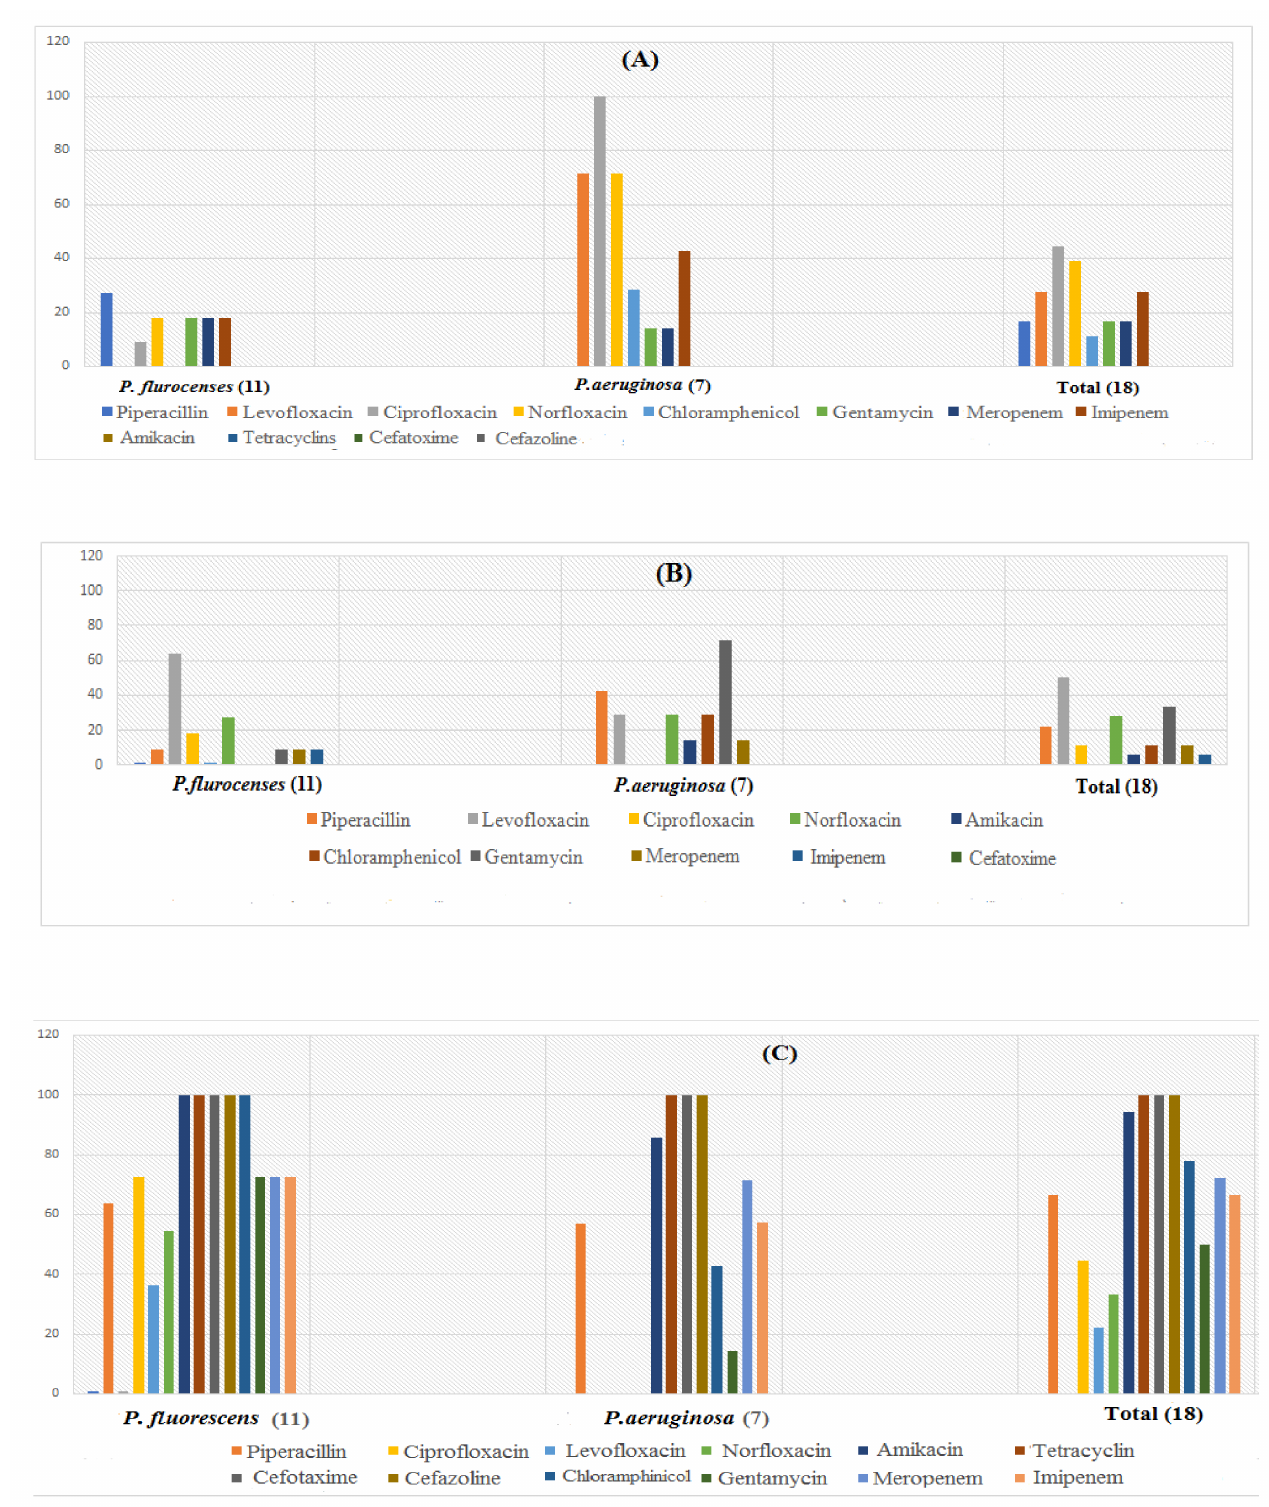
Figure 1. Results of an antimicrobial susceptibility test on Pseudomonas spp. isolates showed that they were variously sensitive ( A ), intermediate ( B ), resistant ( C ) to several